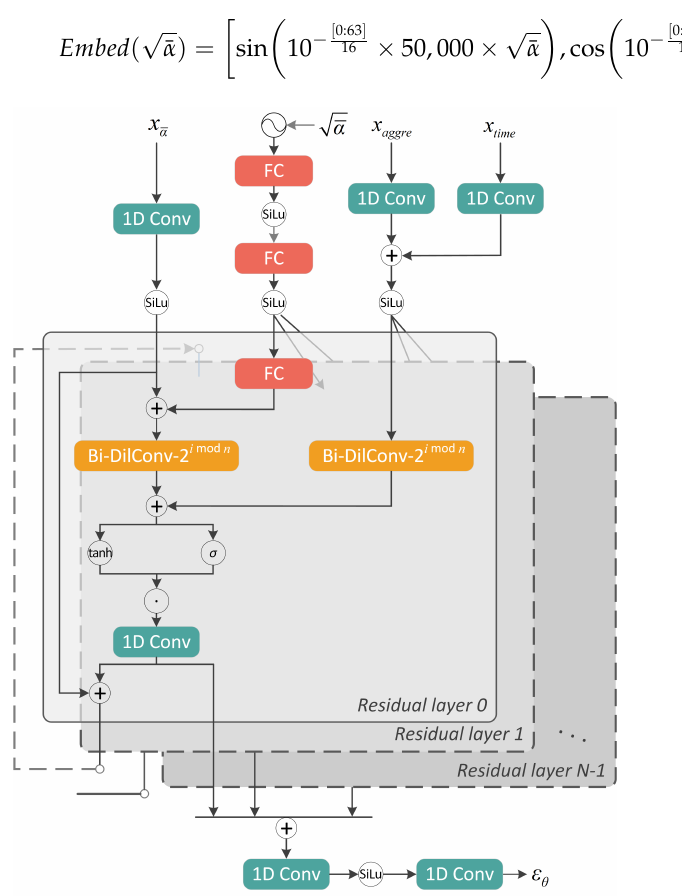
Figure 5. The neural network architecture for noise